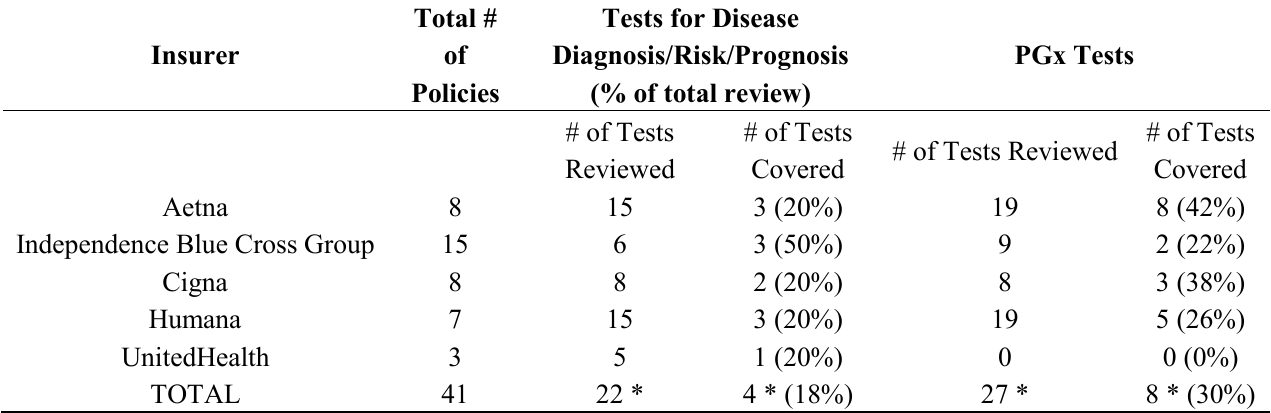
Table 1. Summary of Genomic/Pharmacogenetic (PGx) Coverage Policies by Insurer (policies were identified in August 2012 as described in the Methods